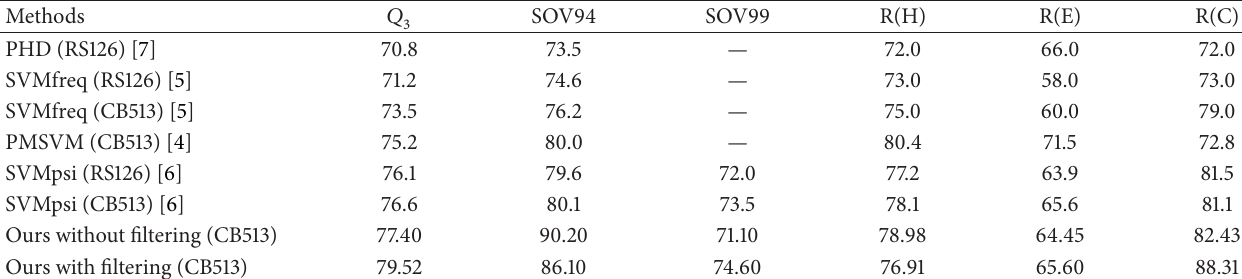
Table 9: Comparisons between ours and other